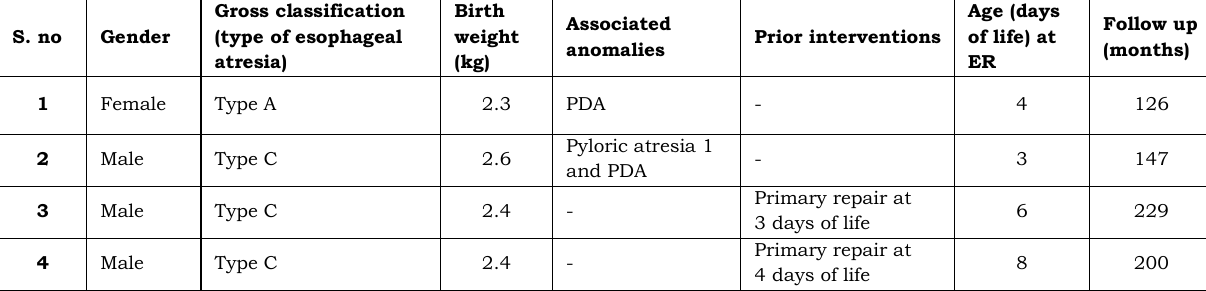
Table 1: Children with neonatal gastric transposition with follow-up more than 10 years